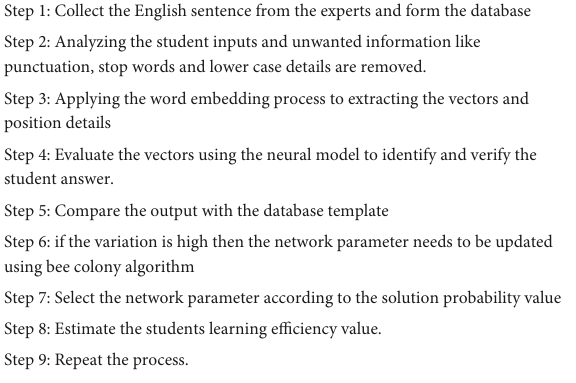
TABLE 1 Working process of HCI with ODNN based